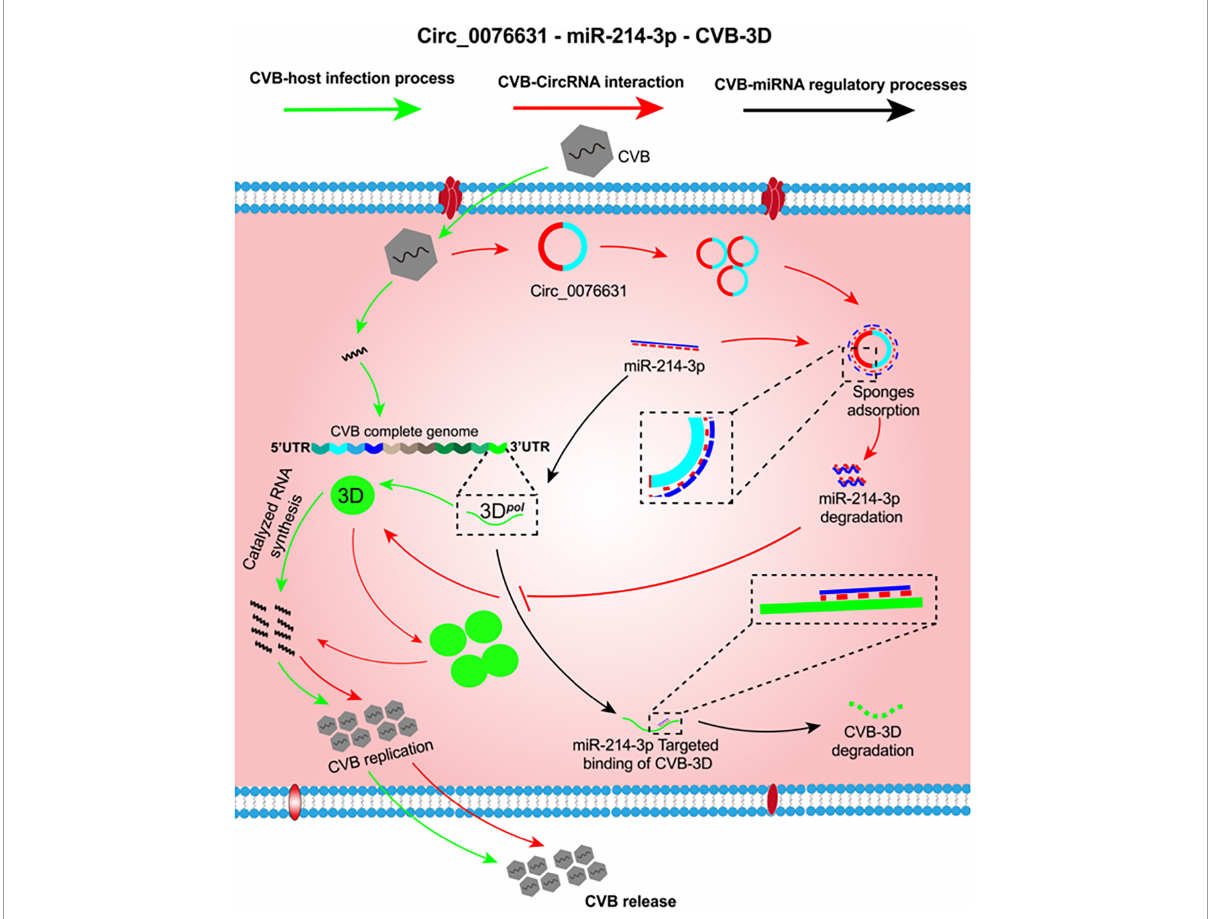
FIGURE7 The putative mechanism of circ_0076631 regulating CVB3 infection by sponging miR-214-3p. At the early stage of CVB3 infection, miR-214-3p is abundant and can suppress viral biosynthesis by targeting the 3D-coding sequence (black lines). Later, CVB3 infection can somehow trigger circ_0076631 generation. Circ-0076631 facilitates CVB3 replication through sponging miR-214-3p and relieving its suppression on CVB3 biosynthesis (red